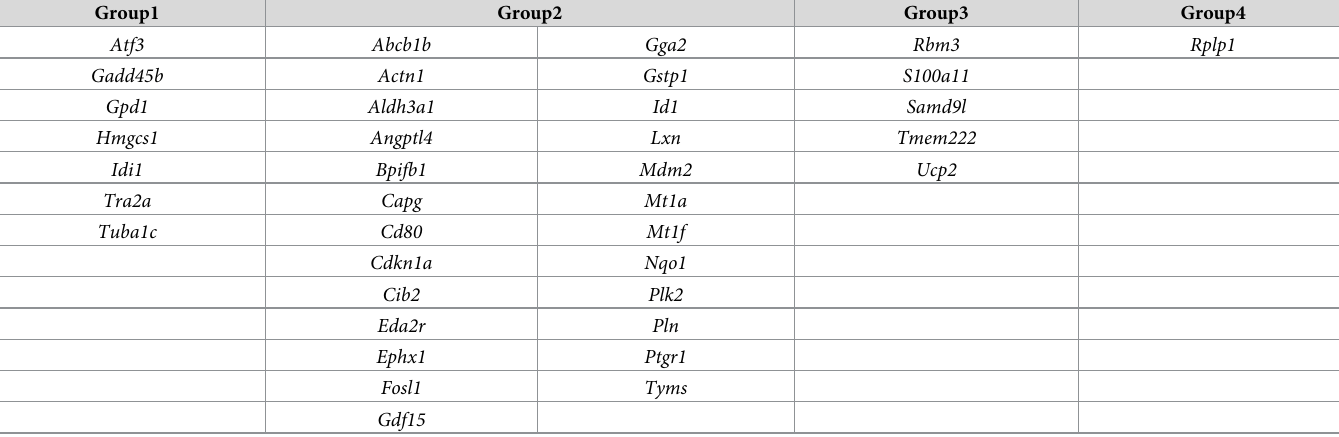
Table 1. List of genes with significantly altered expression in RT-qPCR (biological replicates, n = 3/treatment group).